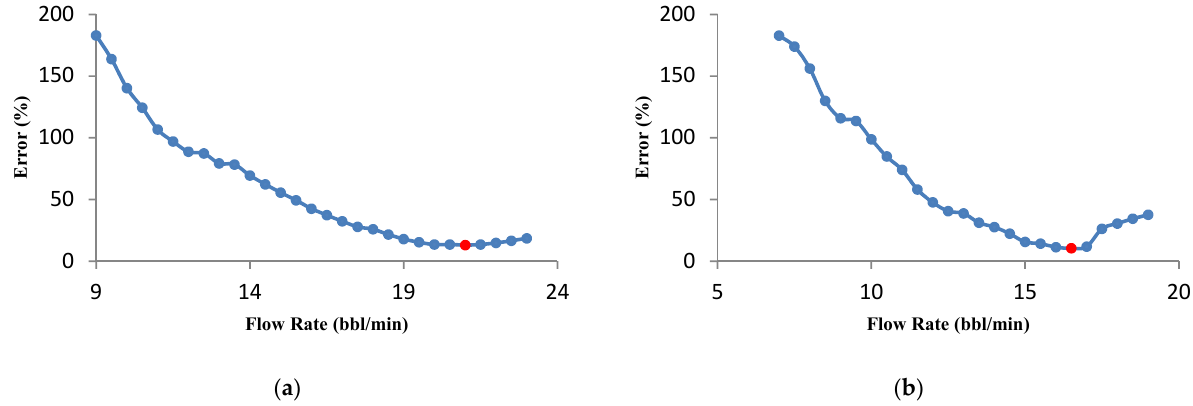
Figure 11. The influence of formation permeability on the optimal injection flow rate for a 1000 bbl acid volume. ( a ) K = 0.001 md and ( b ) K = 0.1 md.